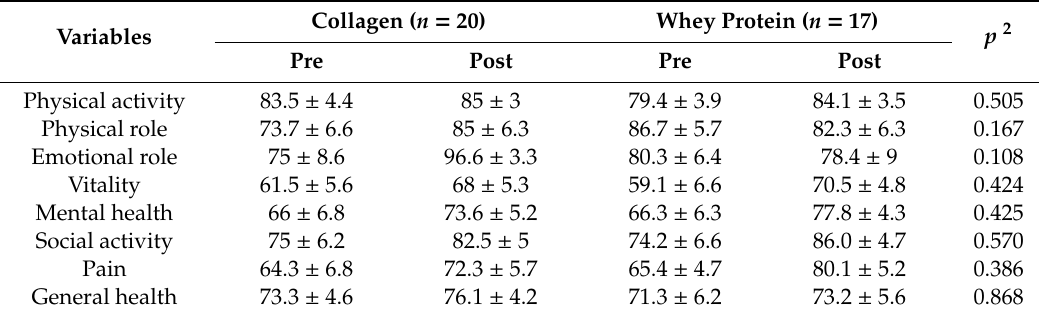
Table 5. Quality of life 1